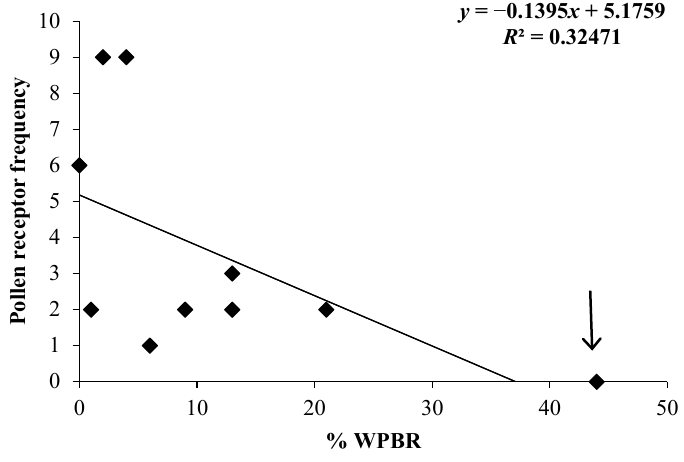
Figure 5. Moderate and negative relationship between the incidence of WPBR and frequency of pollen receptors in a population. Blackwood Canyon is denoted by the arrow.